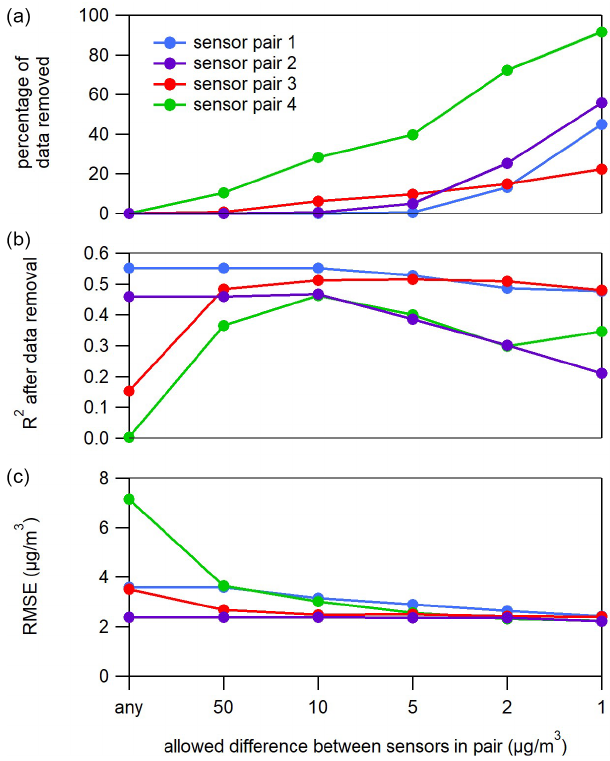
Figure 1. The eight sensor replicas were divided into four pairs with different measurement agreement requirements for the data from the sensors in each pair (first averaged to 1h intervals). The x axis shows the allowed difference between paired measurements. Panel (a) shows the percentage of data removed from the sensor pair for different data agreement requirements. Panel (b) shows how R 2 between the sensor pair (average of the pair) and reference mea- surements changes when these disagreeing data points are removed. Panel (c) shows how RMSE is impacted as disagreeing data points are